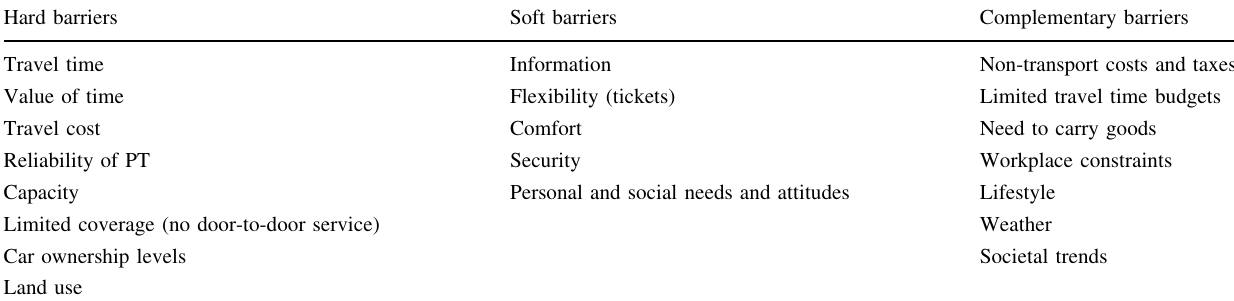
Table 1 Examples of barriers to modal shift (from private to public transport) Source : Derek Halden Consultancy [5] Hard barriers Soft barriers Complementary